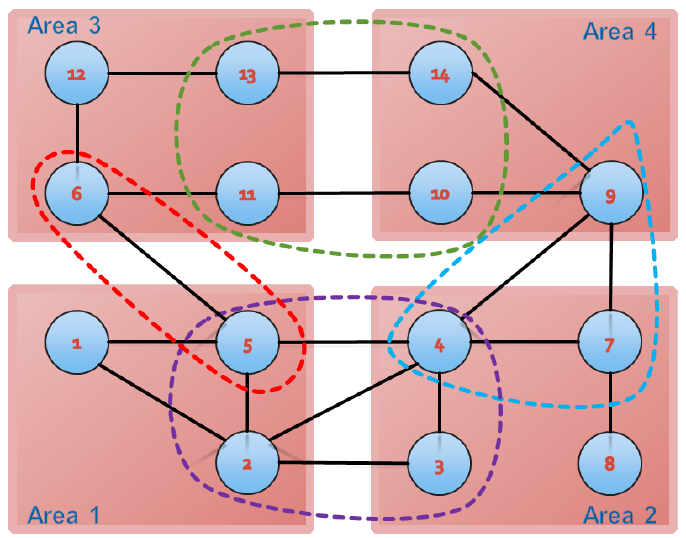
Figure 1. IEEE -14 bus system divided into four areas. Dotted lassos shows the the boundary buses between